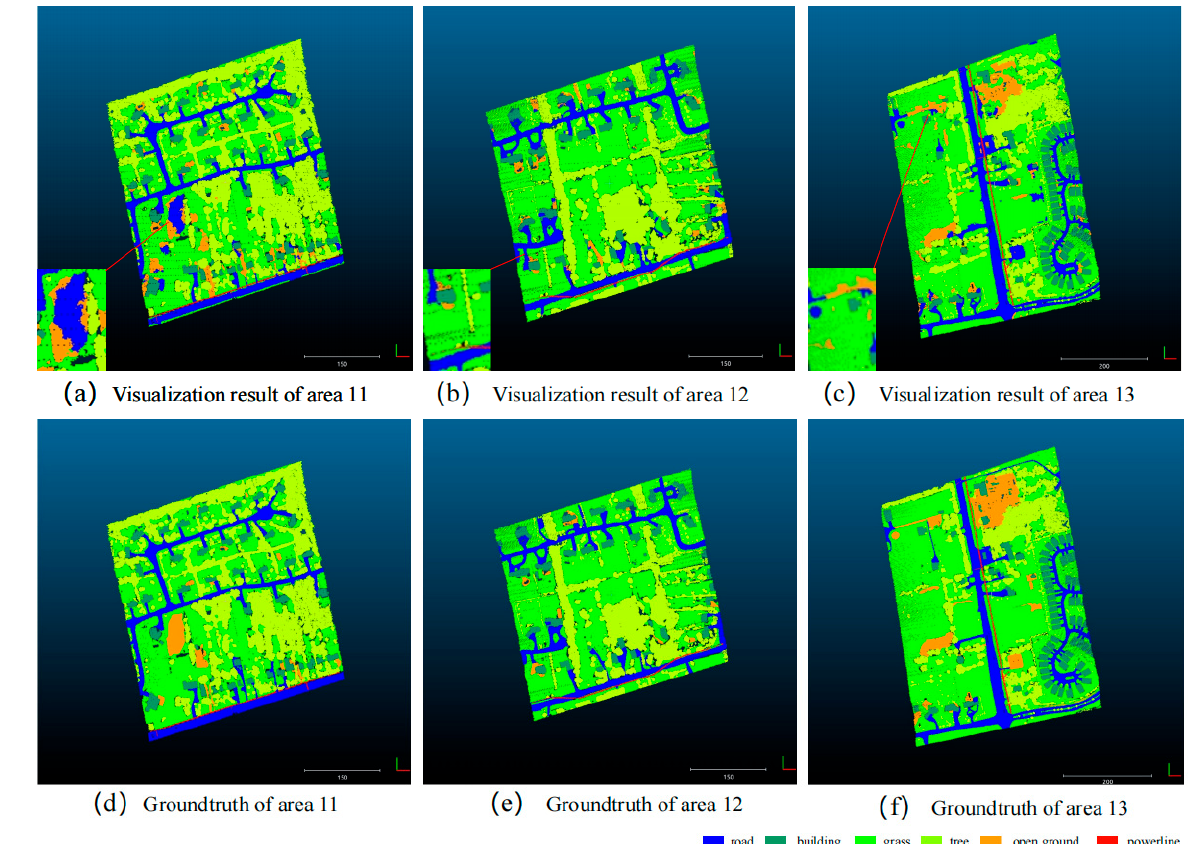
Figure 7. The visualized results and groundtruth for the test areas.